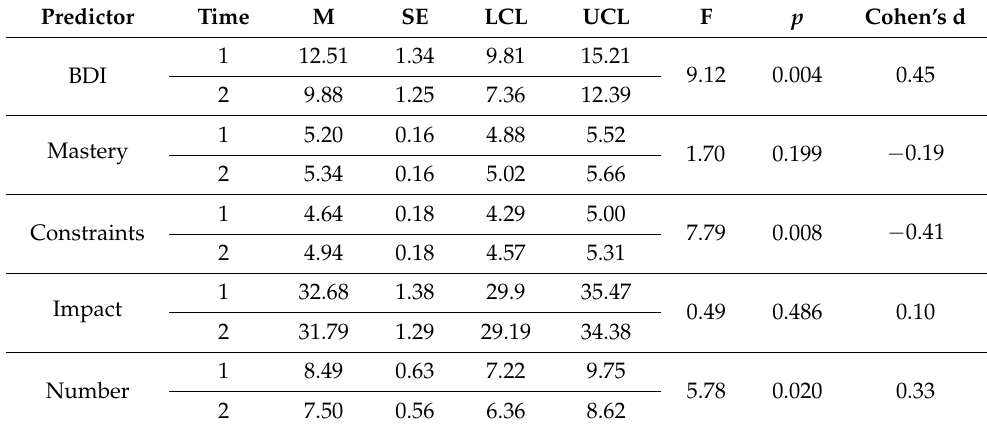
Table 4. Comparisons between T1 and